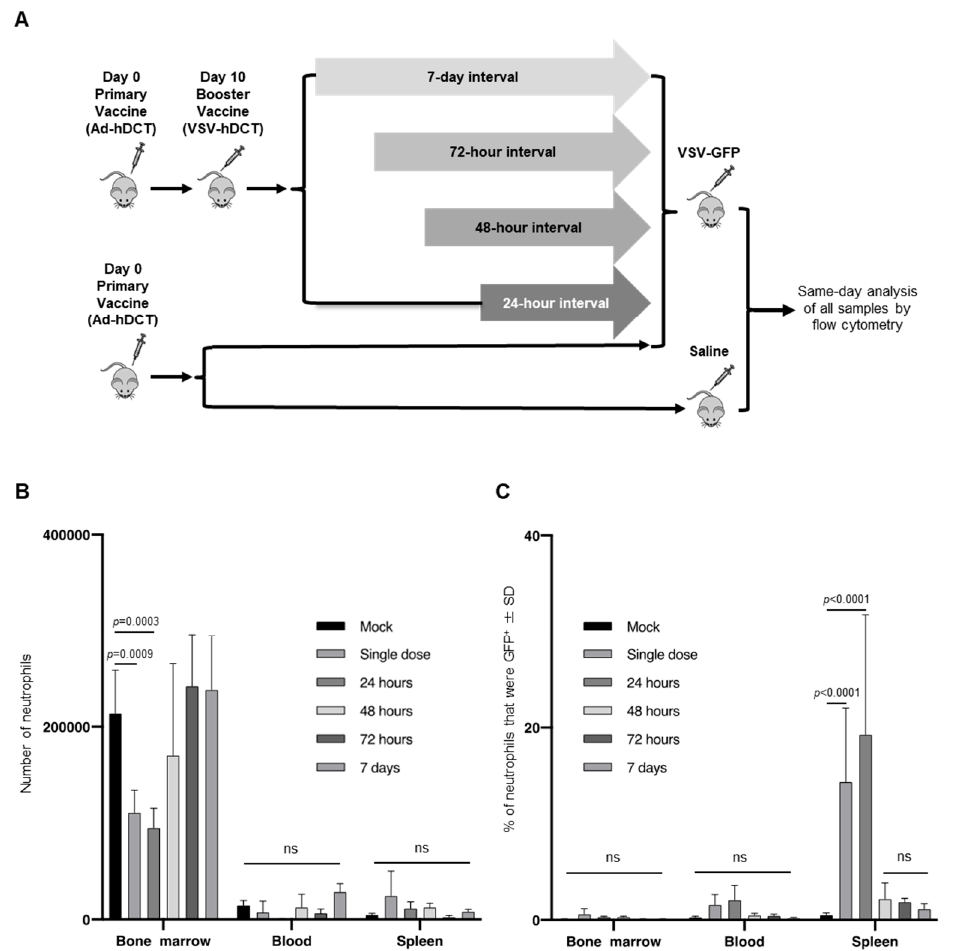
Figure 5. Dosing regimens with vesicular stomatitis virus (VSV) that used a single dose or two doses 24-h apart led to a significant increase in the proportion of splenic neutrophils expressing a viral transgene-encoded protein compared to two doses administered at 48-h or longer intervals. ( A ) In vivo experimental dosing design. Six- to eight-week-old female C57BL/6 mice were injected intramuscularly with 1 × 10 8 infectious units of a replication-deficient human serotype 5 adenovirus vaccine with a transgene encoding the melanoma-associated antigen human dopachrome tautomerase (Ad-hDCT). Ten-days later mice received intravenous injections of 1 × 10 9 plaque-forming units (PFU) of VSV-hDCT as a booster vaccine. Mice received a second intravenous dose of 1 × 10 9 PFU of VSV-GFP at 24-, 48-, 72-h or 7-day intervals. Control mice received a single dose of VSV-GFP or PBS. Initiation of treatments were off-set so that all mice receiving VSV-GFP were treated on the same day. Femur-derived bone marrow, blood and spleens were harvested 18-h after treatment with VSV-GFP for flow cytometric analysis. ( B , C ) Bar graphs with means and standard deviations (SD) ( n = 4/group) show ( B ) numbers of neutrophils (defined as CD45 + Ly6G hi CD11b hi ), and ( C ) the proportion of neutrophils that were GFP + . (ns = not significantly different).